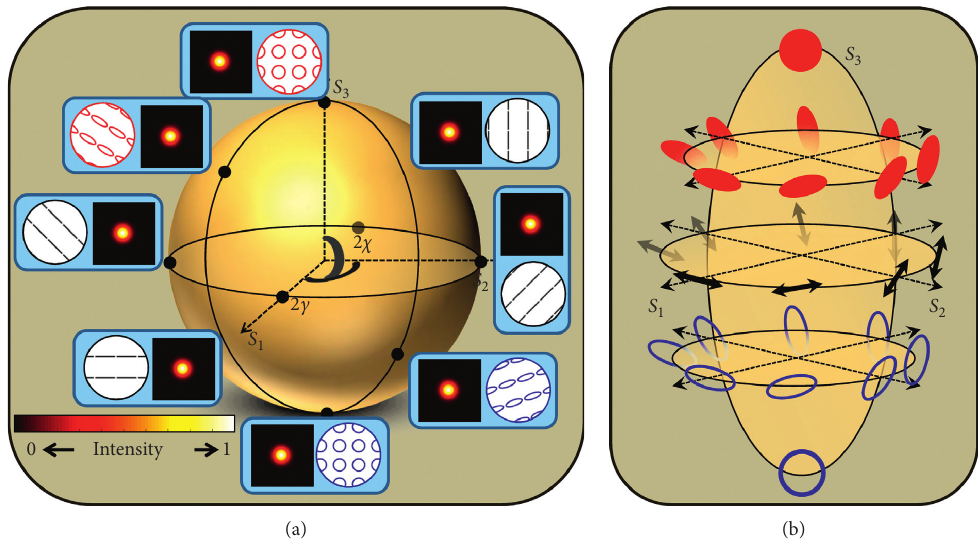
Figure 8: (a) A Poincar´e sphere: geometric representation of homogeneous polarization distribution; (b) polarization variation along azimuth and ellipticity contours. Table 1: Stokes parameters: cyclic rotation of Stokes parameters, S ( i � 1 , 2 , 3 ) in three different decompositions. i , Decomposition Linear Linear diagonal Circular